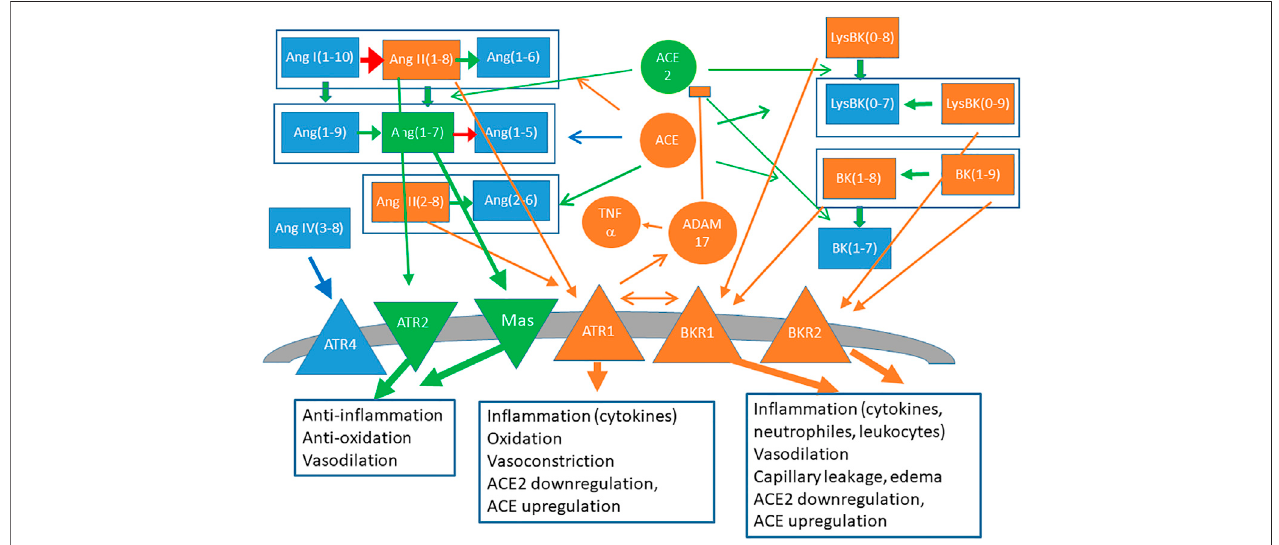
FIGURE1| SchematicrepresentationoftheRAS (left) andbradykinin (right) systems.Signalingpeptidesarerepresentedasrectangles,peptidases(ACE,ACE2), proteases (ADAM17) and cytokines (TNF α ) are represented as circles and membrane receptors are represented as triangles. Components and links with mainly proin fl ammatory character are depicted in orange and anti-in fl ammatory components are depicted in green.